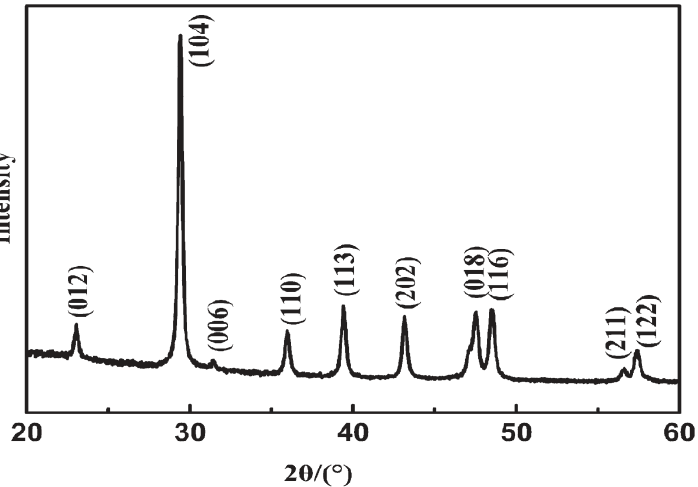
Figure 13. X-ray powder diffraction (XRD) spectrum of calcium carbonate nanoparticles adapted from Chen et al., 2010 (Chen et al., 2010).